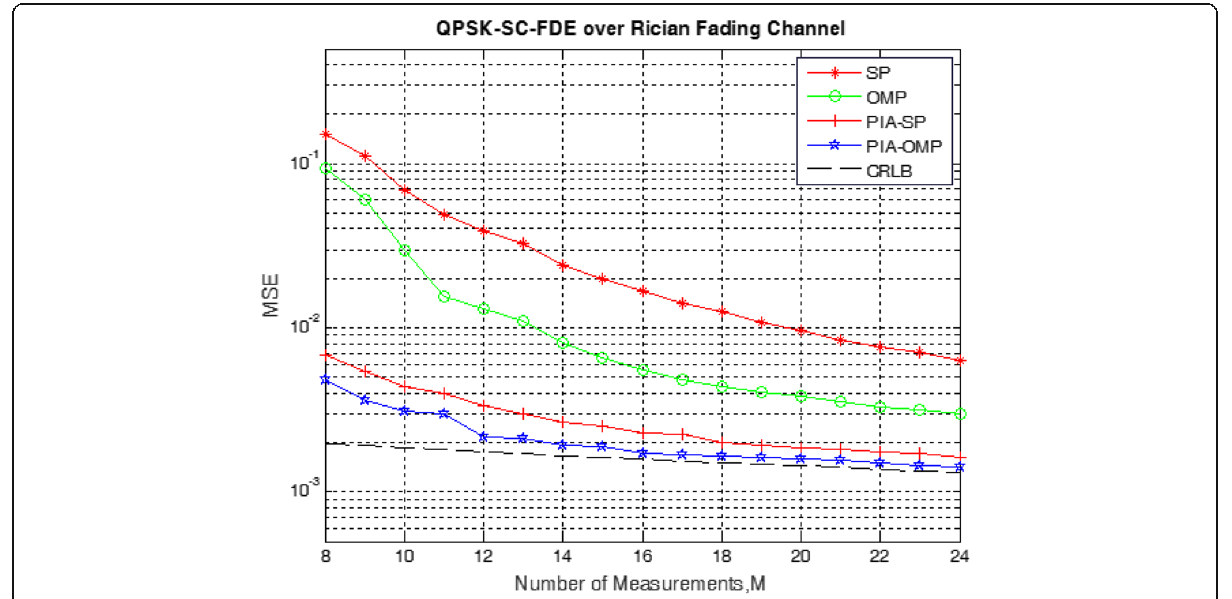
Fig. 6 Signal reconstruction performance when varying number of measurements is utilized with SNR = 15 dB